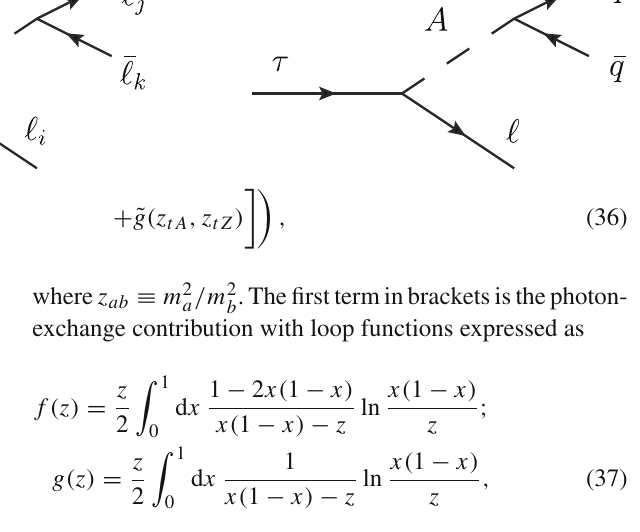
Fig. 4 Feynman diagram for leptonic decay (cid:8) → (cid:8) i (cid:8) j ¯ (cid:8) k (left) and semi-leptonic decay τ → (cid:8) P (right)